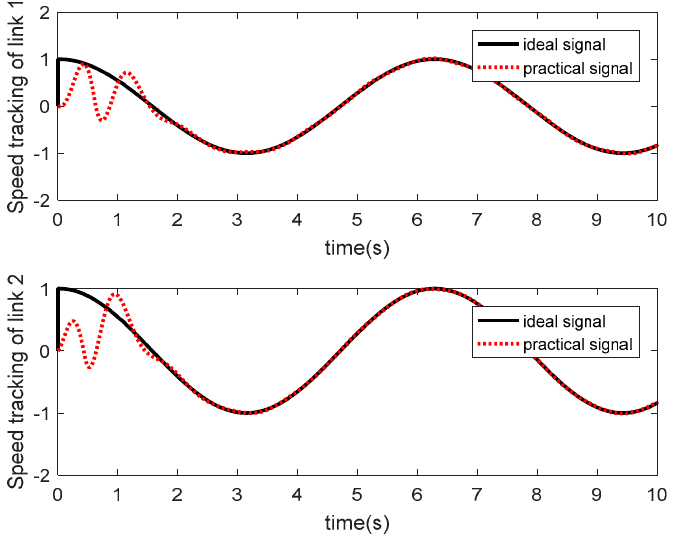
Figure 13. Position tracking of joints 1 and 2.